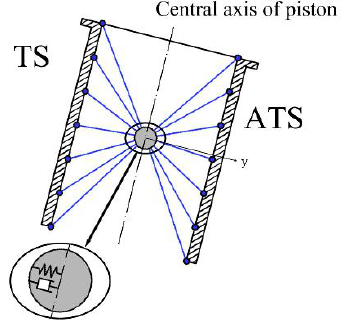
Figure 6. Simplified piston–liner interaction model.